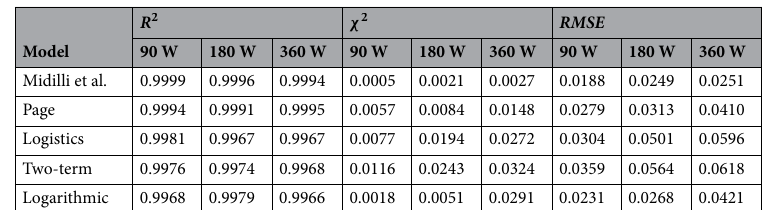
Table 3. The statistical comparison for prediction drying of apple slices in MD dryer.